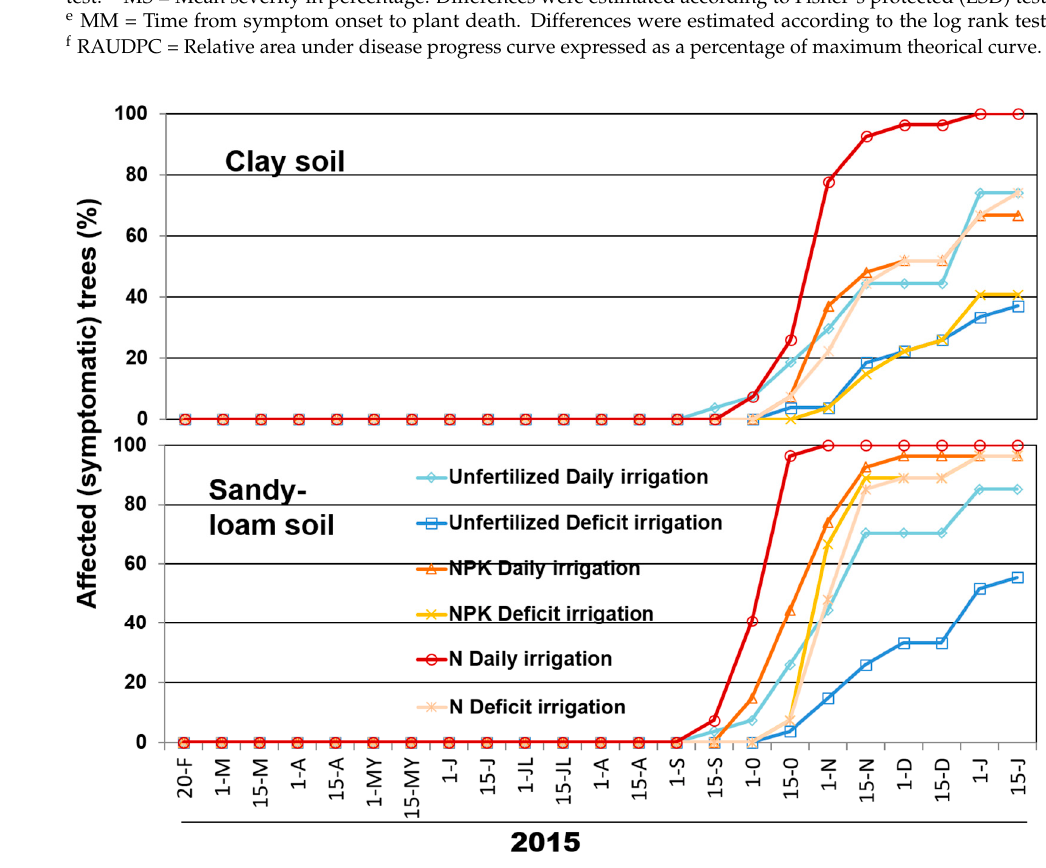
Figure 1. Verticillium wilt disease incidence over time in Picual cultivar olive plants grown in microplots of two naturally infested soils (for more details see Materials and methods section) with Verticillium dahliae and subjected to a combination of two irrigation frequencies: daily and deficit, and three nitrogen fertilization treatments: control without fertilization (Unfertilized), fertilization with N-P-K (15%-15%-15%) (NPK) and fertilization with Calcium Nitrate (15.5%-0-0) (N). After 11 months of observations in clay soil, the percentage of trees killed by the pathogen was significantly ( p = 0.0256) lower in plants unfertilized and fertilized with NPK (average Mortality value of 12.9% and 11.1%, respectively) than plants fertilized with N (average value of 31.4%) (Table 1). However, in sandy-loam soil this percentage was significantly higher ( p = 0.0134) in plants fertilized with NPK and N (average value of 48.1 and 53.7, respectively) than plants unfertilized (average value of 12.9%) (Table 2). In this soil, the mortality in ‘Picual’ plants that were irrigated daily reached values significantly higher ( p = 0.0205) compared with ‘Picual’ plants under deficit irrigation (53.08% and 23.45%, respectively). In clay soil, no significant differences were detected among irrigation treatments ( p = 0.1296). At the end of the assessment period, in sandy loam soil, the mean time from symptom onset to plant death (MM parameter) was significantly shorter in trees under the treatment N-daily (3.7 weeks) than for plants of the other treatments (Table 2). In clay soil no differences were found (Table 1). Significant differences regarding the final value of RAUDPC among treatments varied depending on the soil. In clay soil, the factors fertilizer and irrigation were significant, with p value = 0.0119 and p value = 0.0351, respectively. The mean value of RAUDPC calculated in plants N-fertilized were significantly higher (49.1%) than the mean value obtained in plants unfertilized, and plants fertilized with NPK. In sandy-loam soil, the three analyzed factors (fertilizer, irrigation and interaction fertilizer-irrigation) were significant ( p < 0.05). Picual trees that were daily irrigated and fertilized with N reached RAUDPC values of 94.3% (58.4% significantly higher than the mean value obtained in the rest of treatments) followed by plants daily irrigated and fertilized with NPK, which